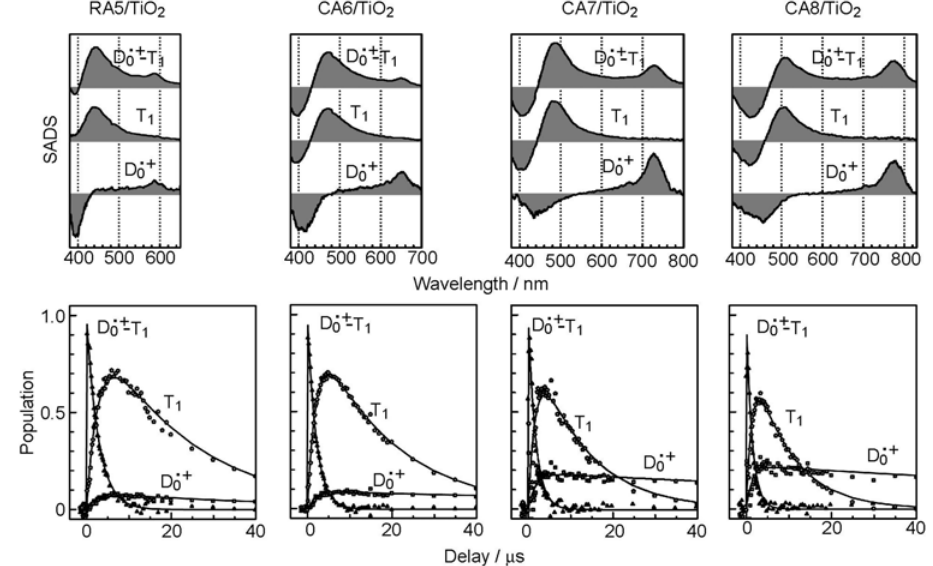
Figure 10. SADS (upper panels) and time-dependent changes in population (lower panels) nanoparticles in suspension (reprinted with permission from for RA5~CA8 bound to TiO 2 [11] © 2005, American Chemical